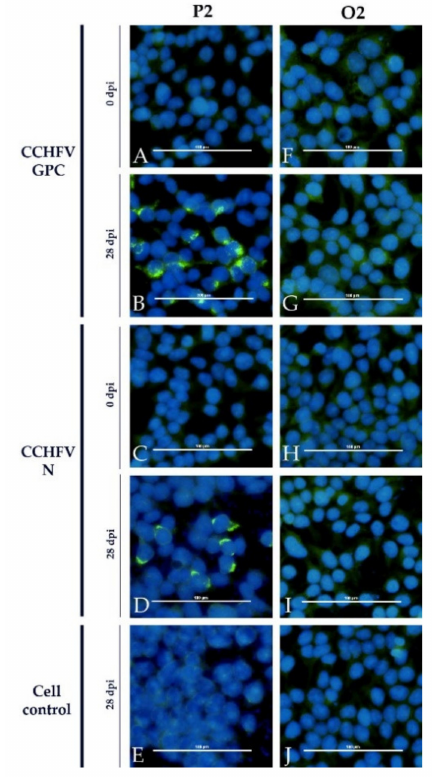
Figure 6. Euroimmun iIFA with sheep NSDV antisera: The results obtained with the serum of an infected sheep (P2) are presented as an example together with the results for the control sheep (O2). A specific staining is demonstrated for cells expressing CCHFV GPC ( B ) as well as CCHFV N ( D ) for P2. All controls (cell control: ( E ); serum prior to infection: ( A , C )) did not lead to a positive signal. The control sheep O2 did not test positive in any condition ( F – J ).